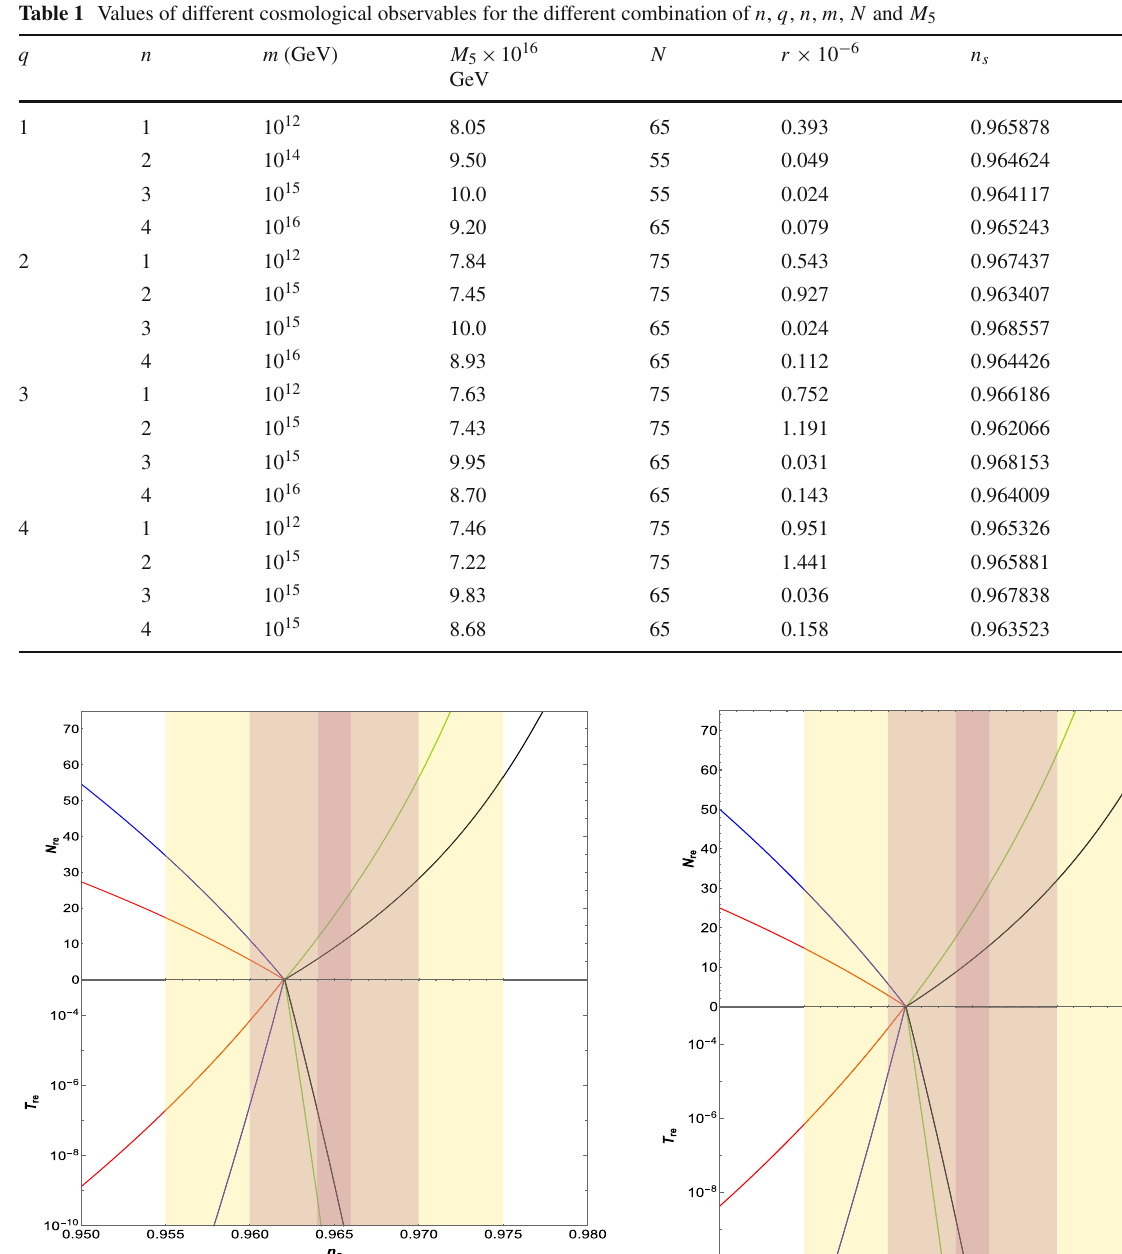
Fig. 5 For the choice of n = 3 , q = 1, Plots of N re and T re as a function n s for different values of w re . The red line corresponds to w = − 1 / 3, the blue line corresponds to w re corresponds to w re = 2 / 3 and finally the black line corresponds to w = 1. The light pink shaded region corresponds to the 1- σ bounds re and yellow shaded region corresponds to the 2- σ bounds on n s from Planck’18 [TT,TE,EE+lowE+lensing+BK15].Thedarkpinkshaded region corresponds to the 1- σ bound of future CMB observations [52, 53] using same central value for n s